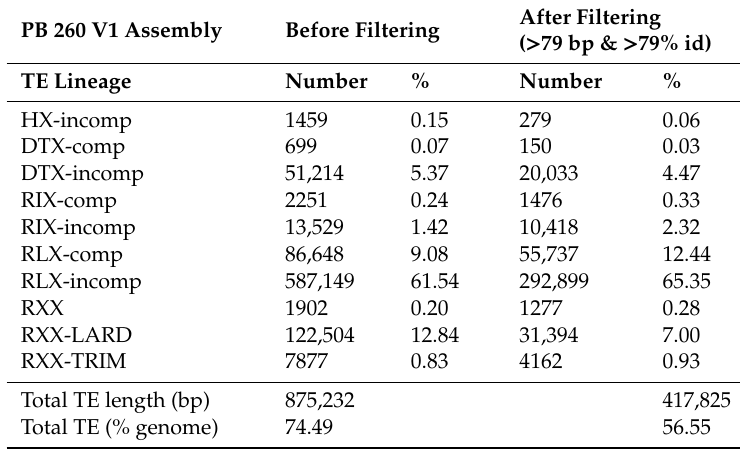
Table 1. Statistics of TE annotation of genomic sequences from clone PB 260 by REPET according to Wicker’s classification